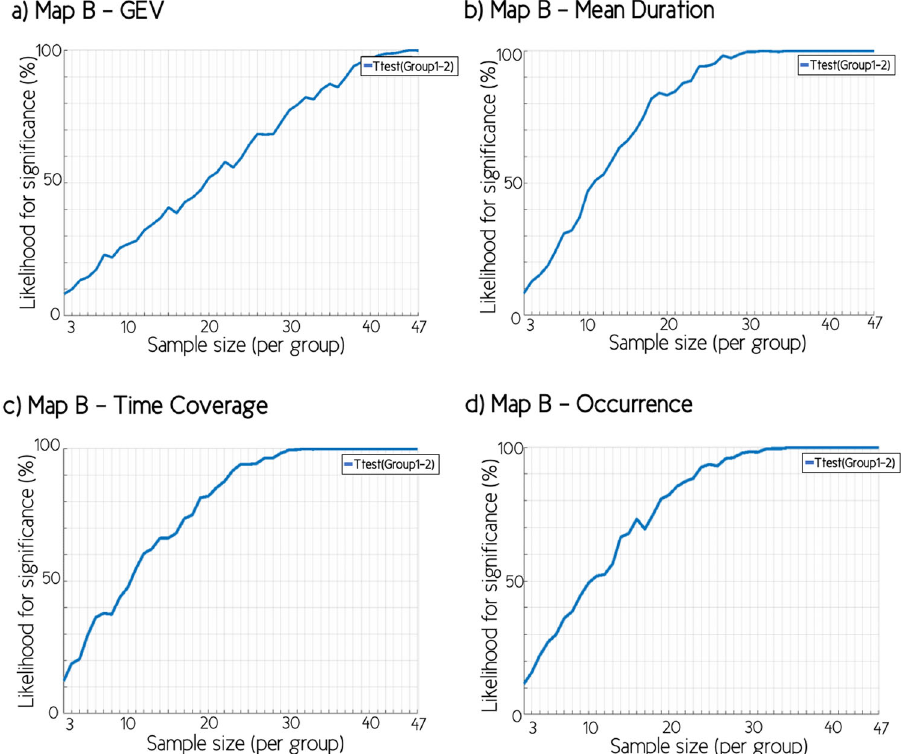
Fig. 5 Bootstrapping analyses. The likelihood to observe a signi fi cant difference between toddlers and preschoolers with autism spectrum disorders (ASD) and their typically developing (TD) peers, simulating sample sizes ranging from 3 to 47 individuals in each group, for parameters of microstate class B: a global explained variance (GEV); b mean duration; c time coverage; and d